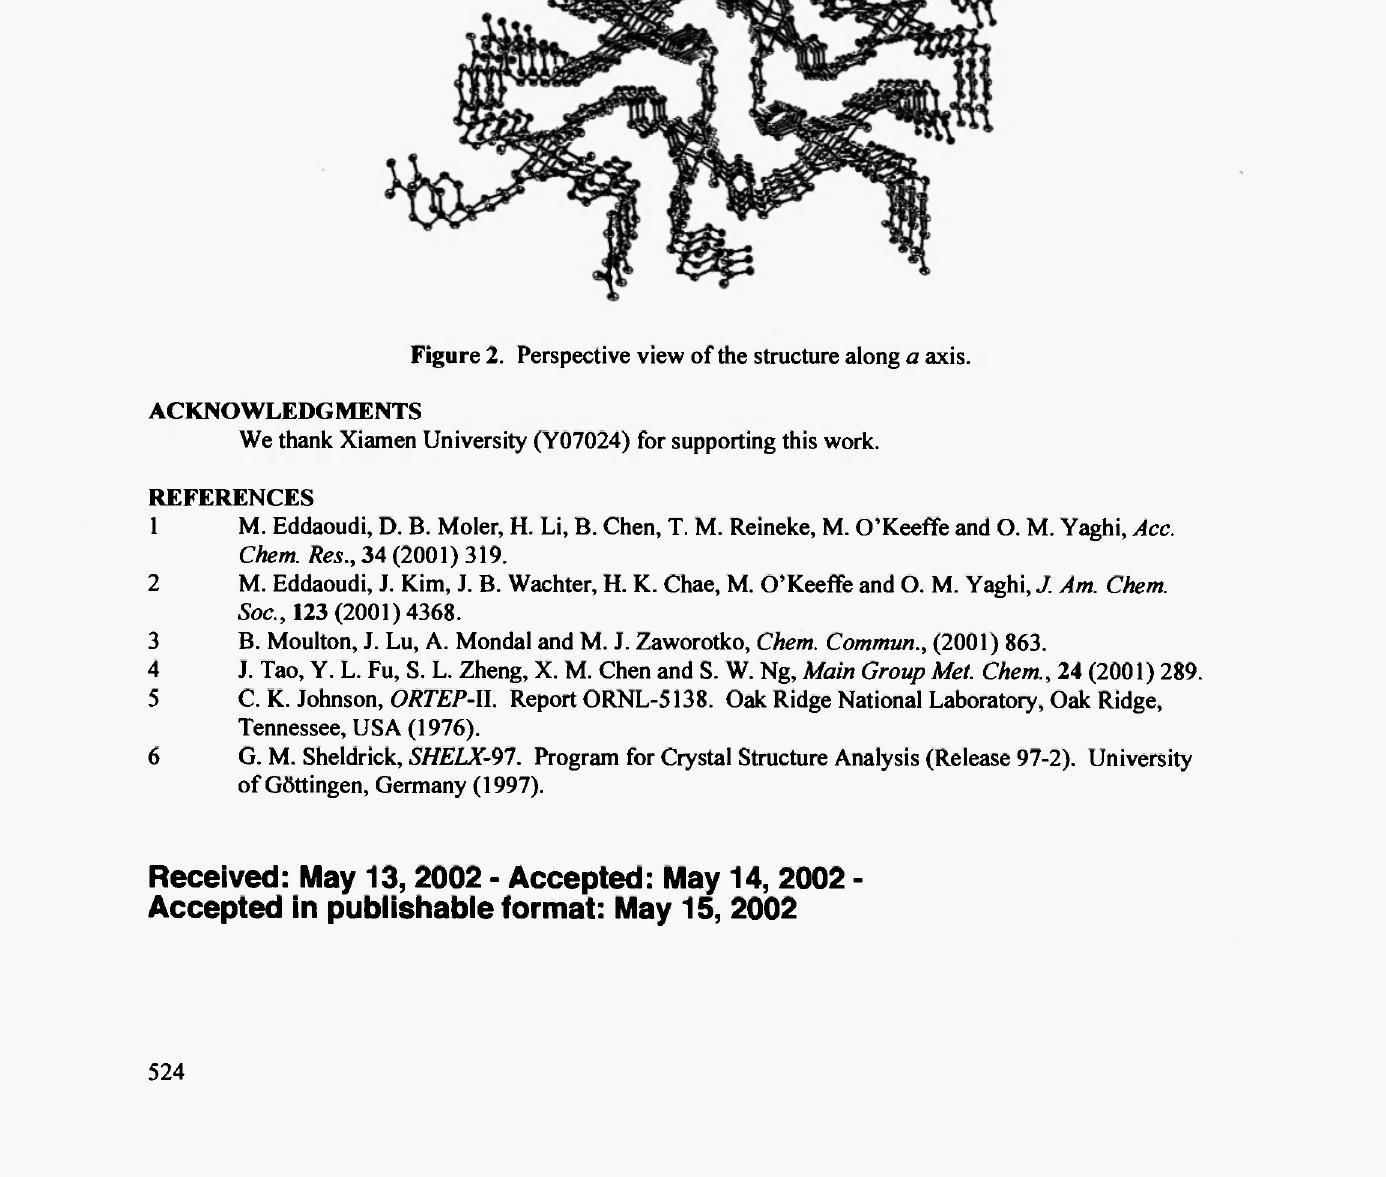
Figure 2. Perspective view of the structure along a